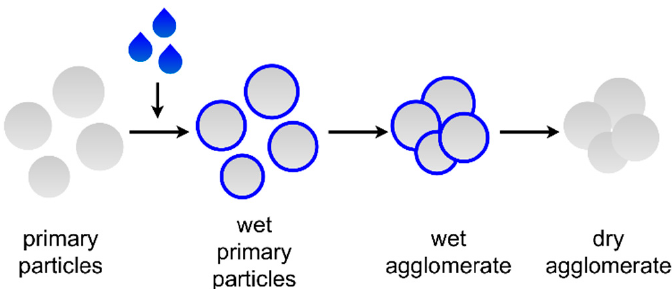
Figure 1. Schematic representation of the formation of agglomerates.